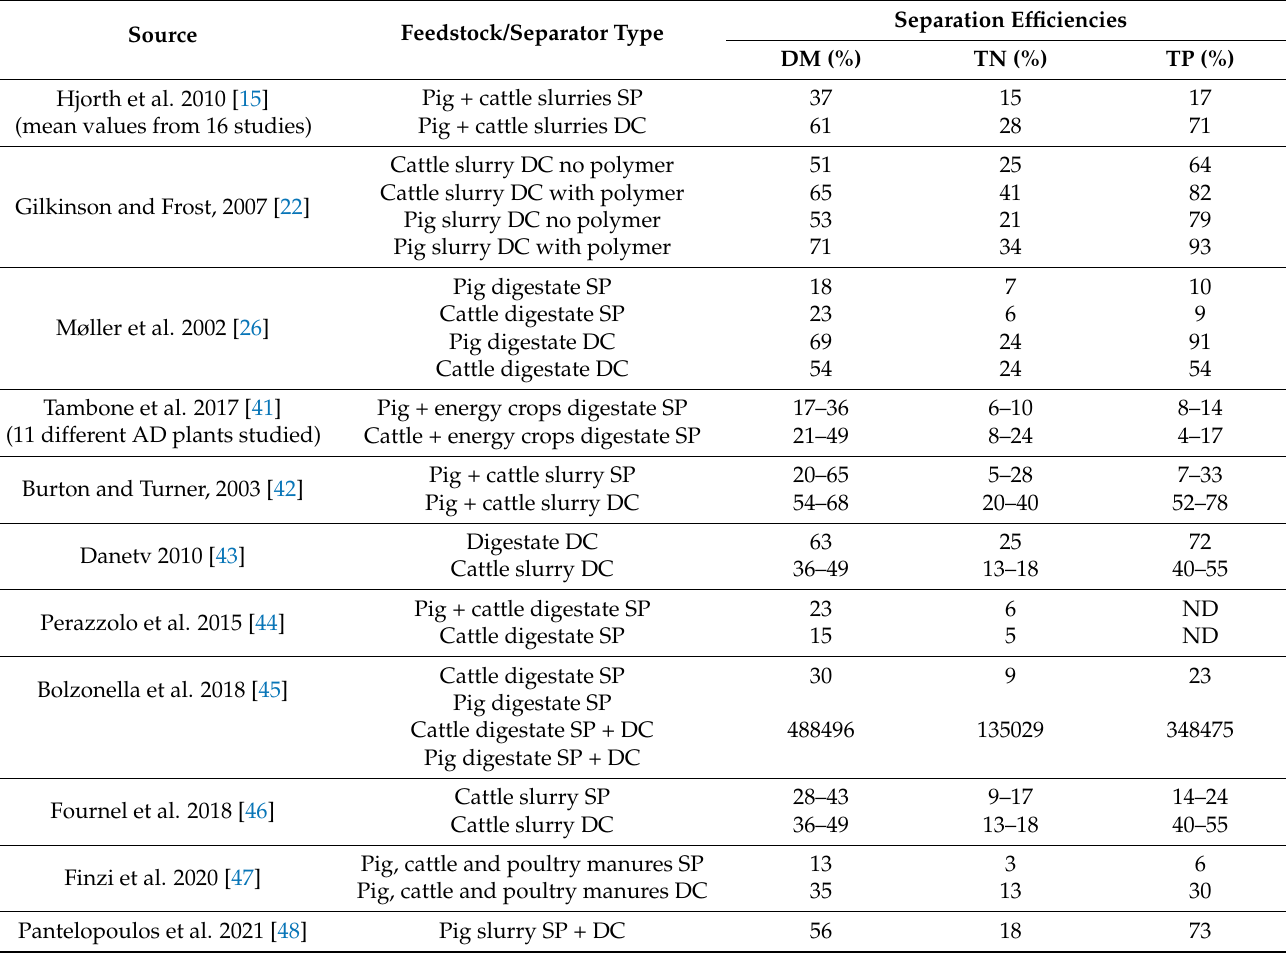
Table 2. Screw press (SP) and decanting centrifuge (DC) separation efficiencies for dry matter (DM), total nitrogen (TN), and total phosphorous (TP) reported in a number of studies. Separation efficiency is quoted as the percentage of the analyte from the input feedstock that was partitioned to the solid fraction. One of the studies did not report data for TP